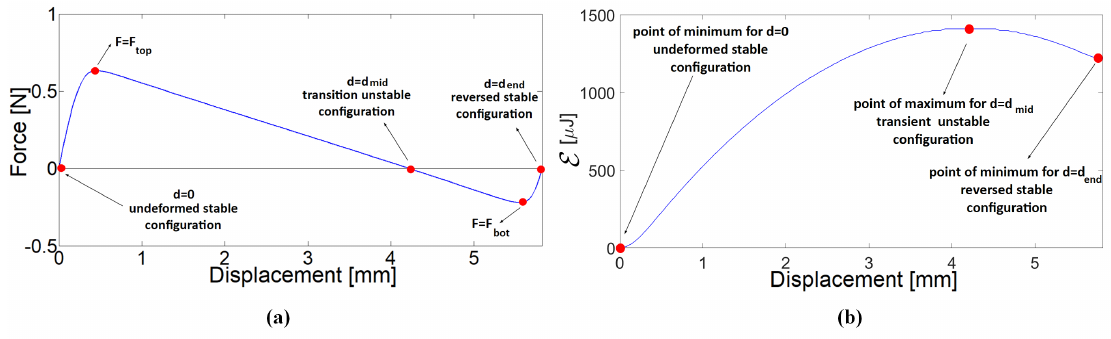
Figure 6. Force–displacement curve ( a ) and strain energy–displacement curve ( b ) obtained from the nonlinear static